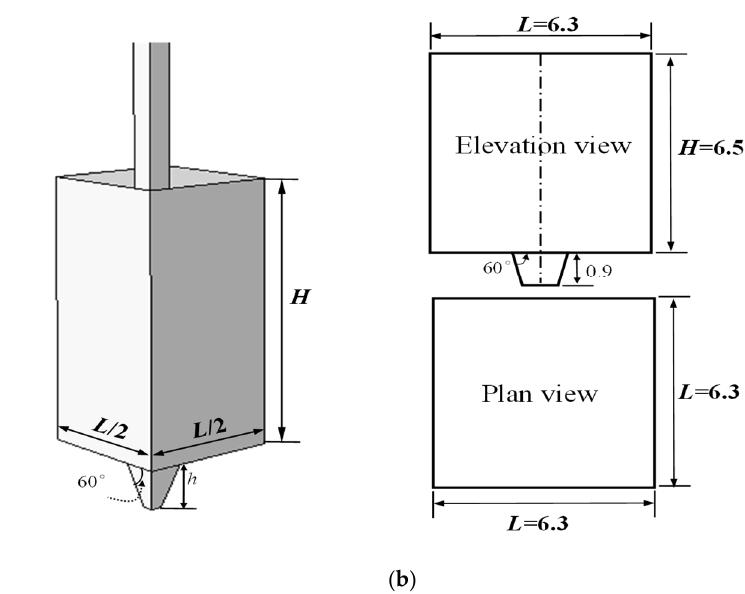
Figure 1. Schematic diagram of a quarter foundation: ( a ) generic spudcan; ( b ) cubic spudcan (m).